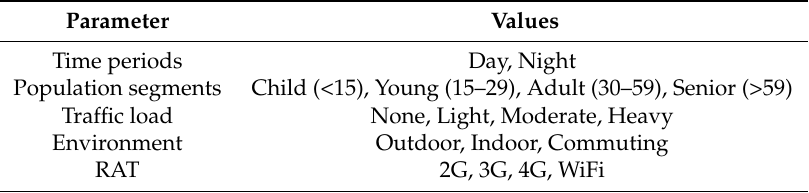
Table 3. Reference scenario for life segmentation data